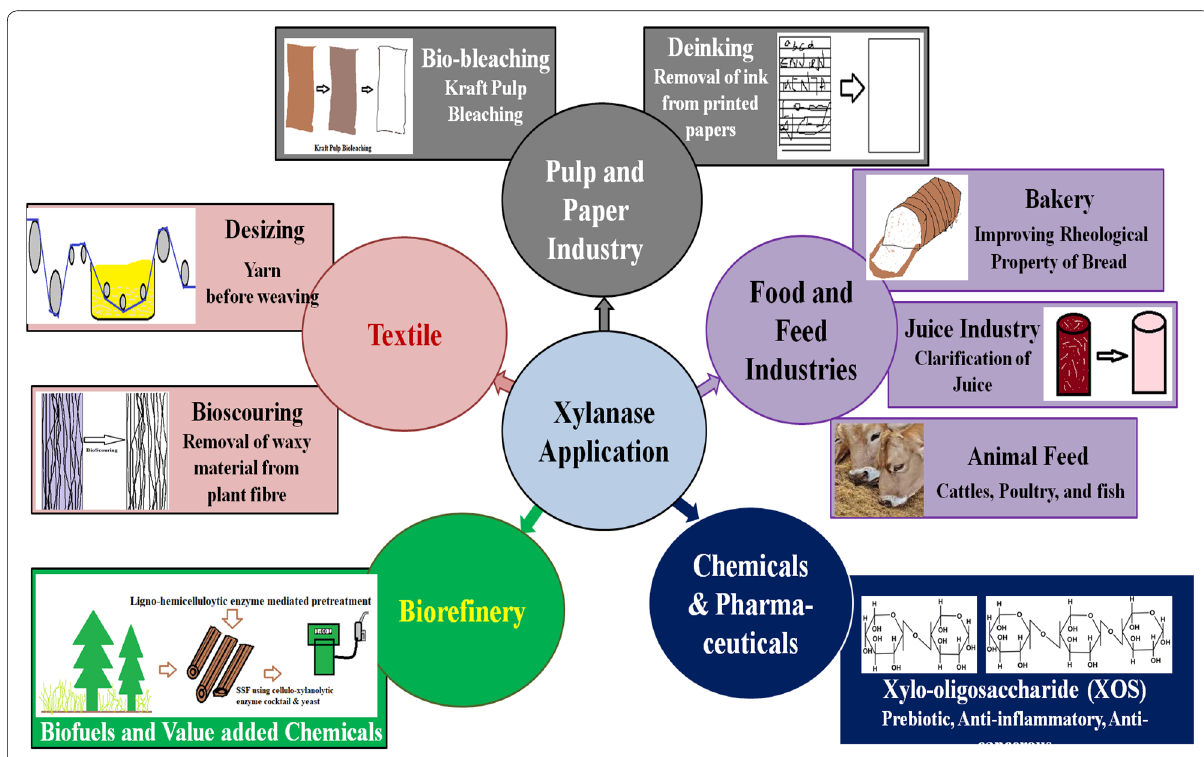
Fig. 6 Xylanase as a greener tool in different